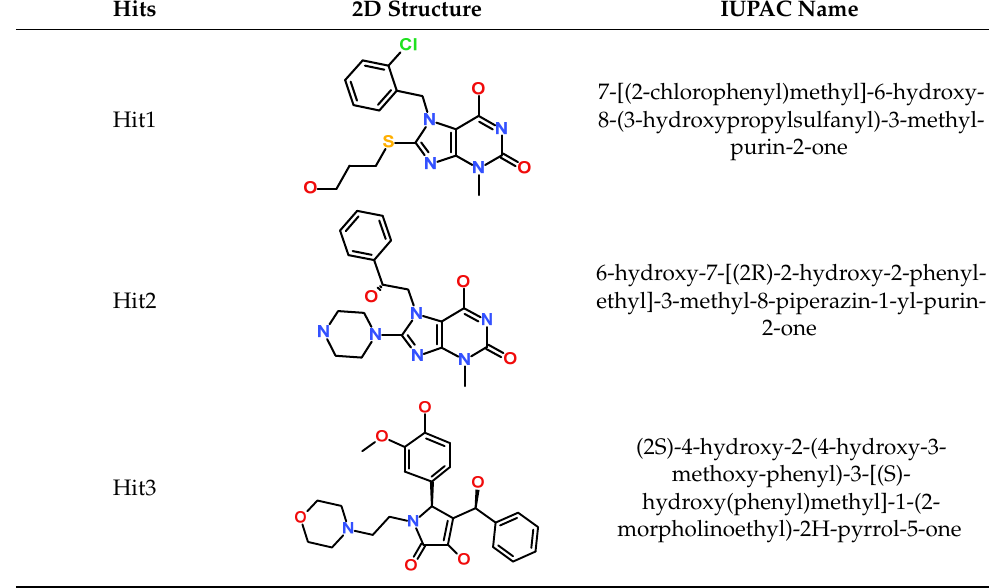
Table 5. The 2D chemical structure of the identified scaffolds and IUPAC names. Hits